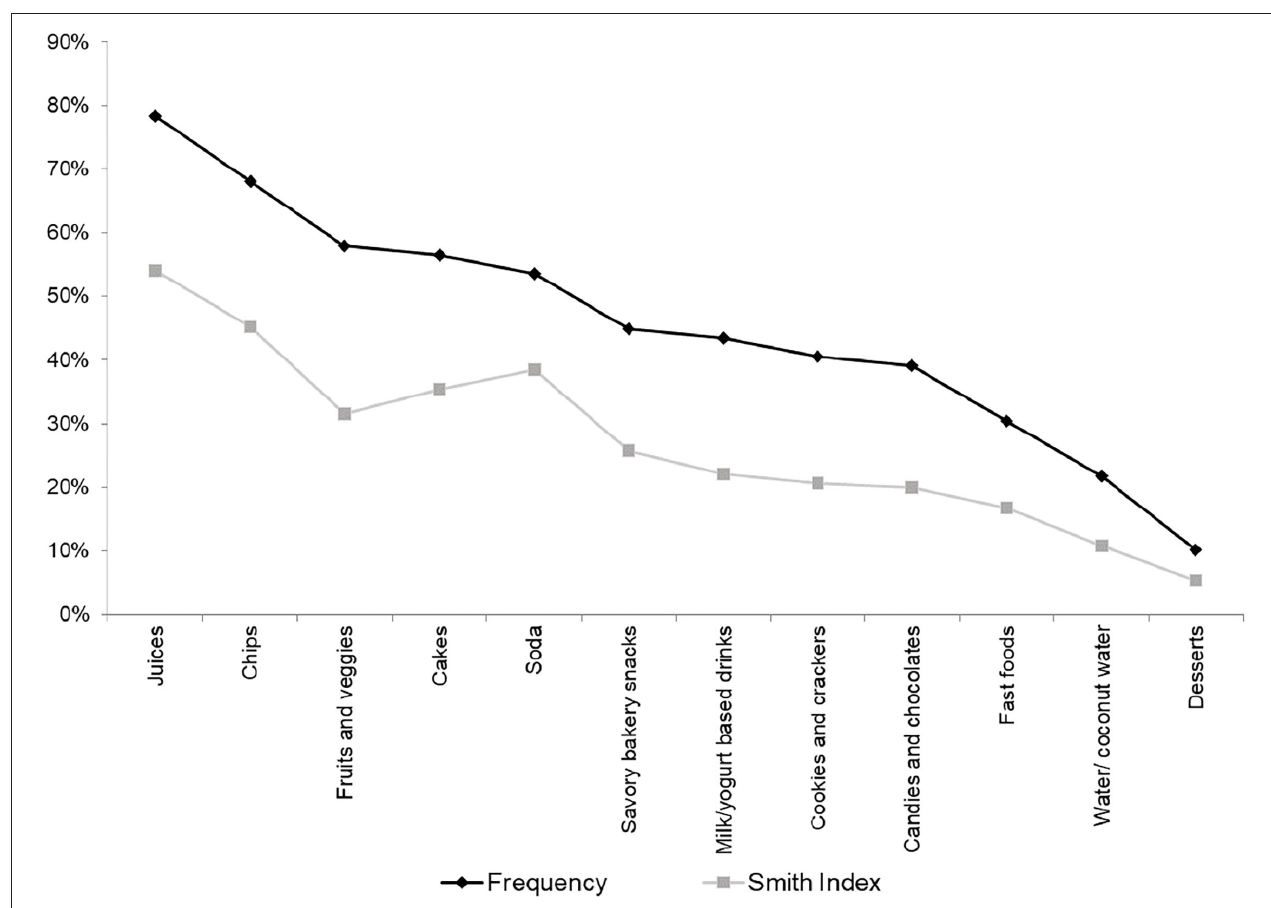
FIGURE 1 | Free lists results by the frequency of the foods/drinks, São Paulo, 2019.